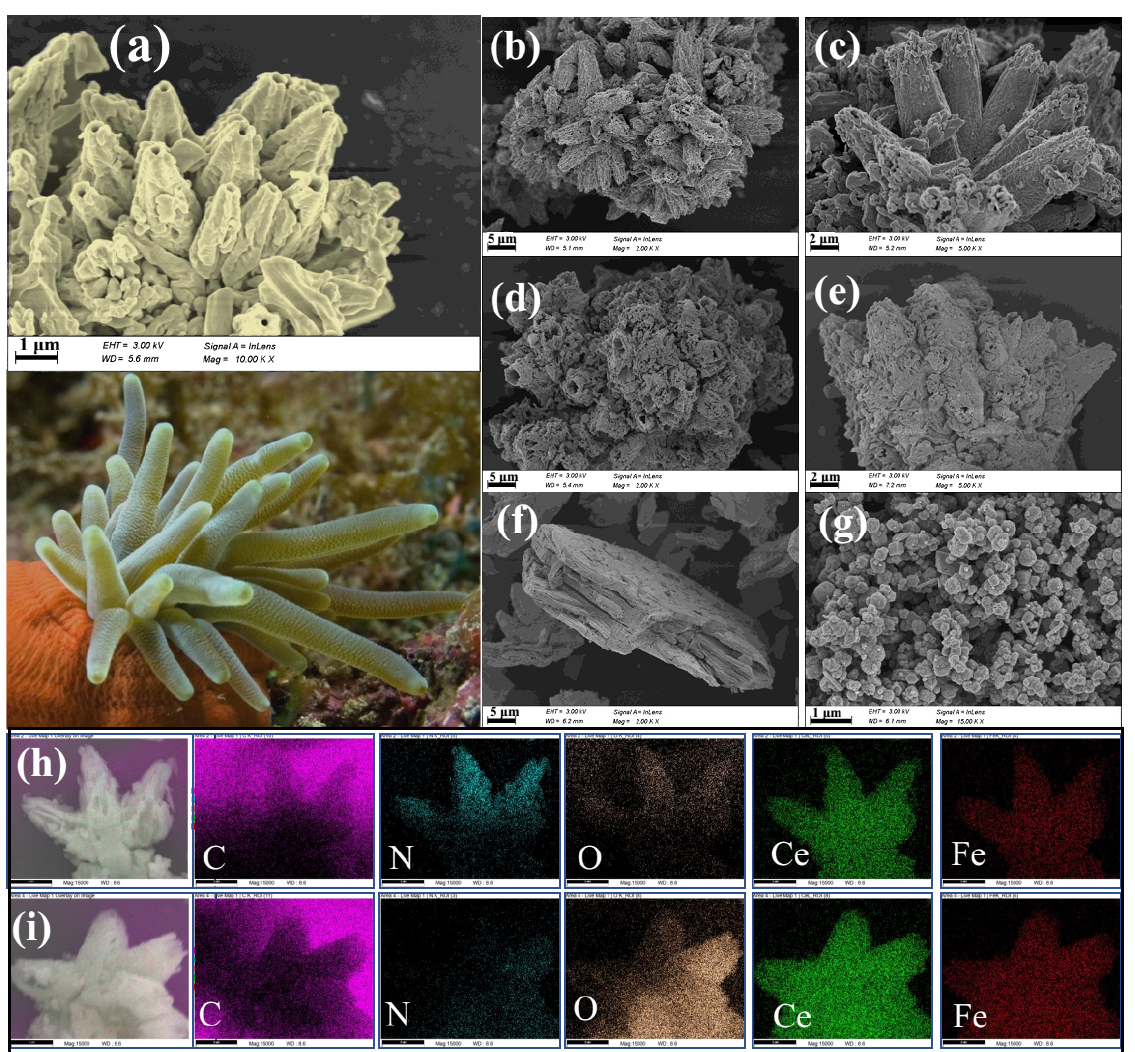
Figure 1. SEM images of ( a – c ) CeFe-CM, ( d , e ) CeFe-CM-T, ( f ) CeO 2 , and ( g ) Fe 3 O 4 . Element mapping of ( h ) CeFe-CM and ( i ) CeFe-CM-T.